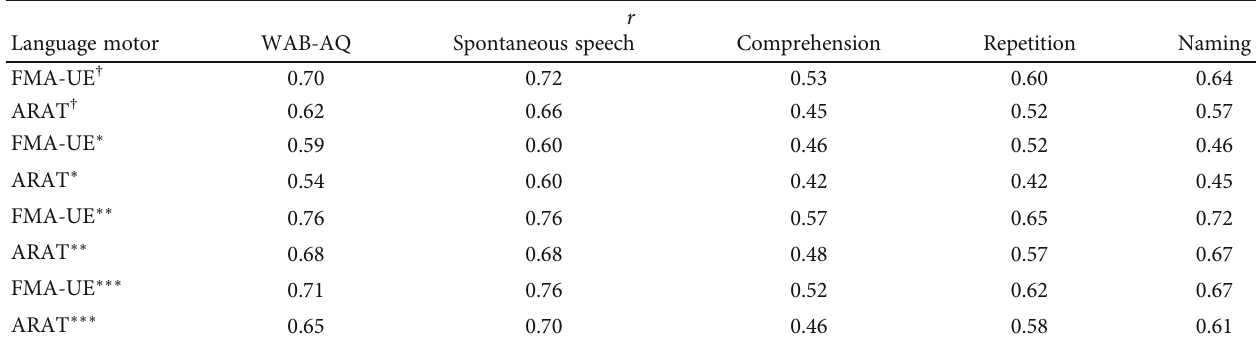
Table 2: Pearson ’ s correlation between four parts of WAB-AQ and FMA-UE and ARAT scores.